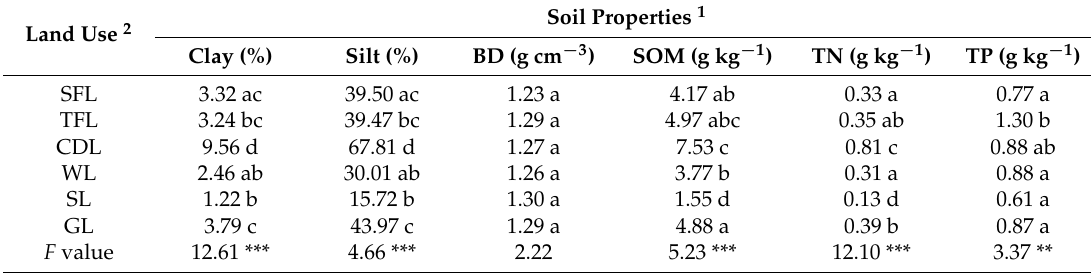
Table 3. Comparison of soil properties for different land use